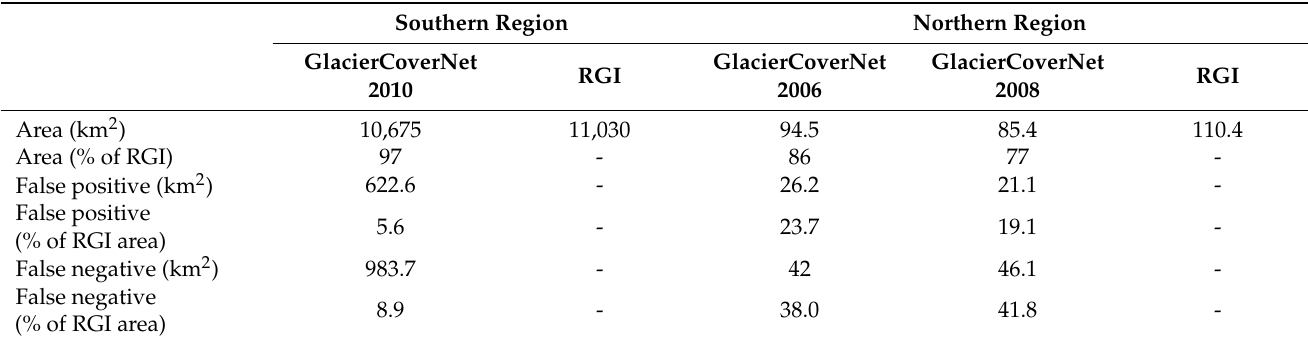
Table 3. GlacierCoverNet outputs for 2010 (southern region) and 2006 and 2008 (northern region). Values are based on model outputs for areas in the validation set.